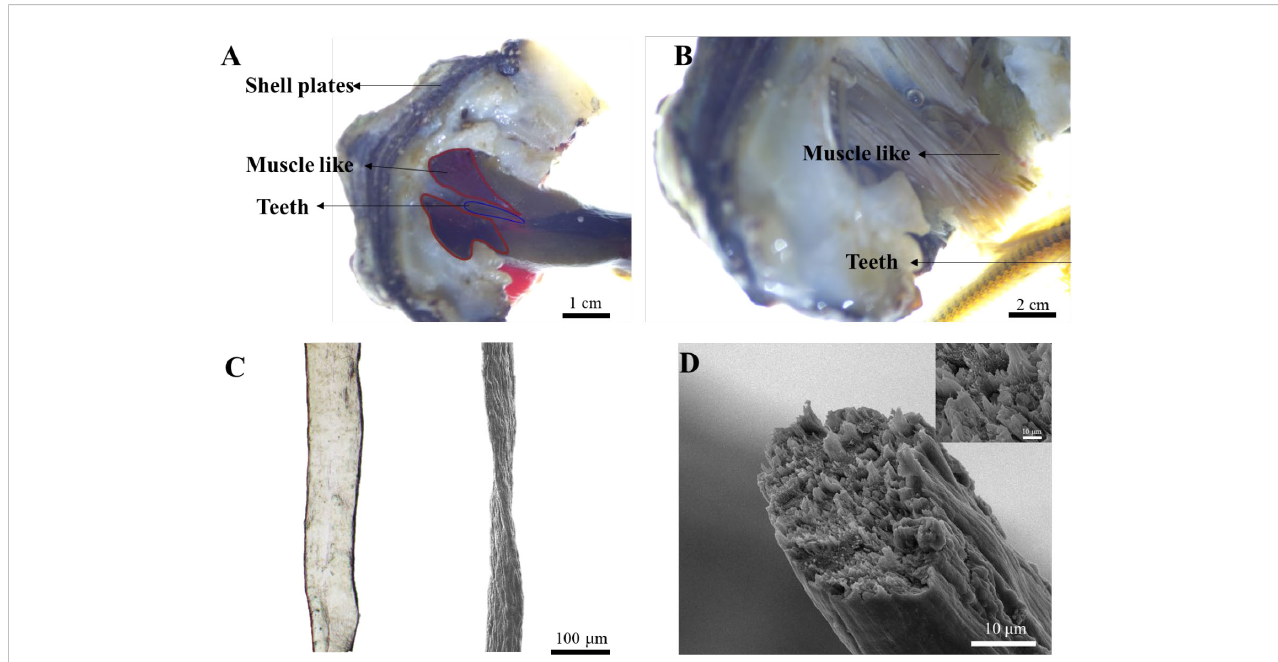
FIGURE 2 Isolation, dissection, and visualization of radular muscle-like tissues. (A) Dissection of muscle-like tissue around the radula. (B) The magni fi ed image of muscle-like tissue and the teeth under a stereo microscope. (C) The optical (left) and SEM image (right) of a single radular muscle-like fi ber (D) The cross-sectional SEM image of a single fi ber. The inset is the magni fi ed image.